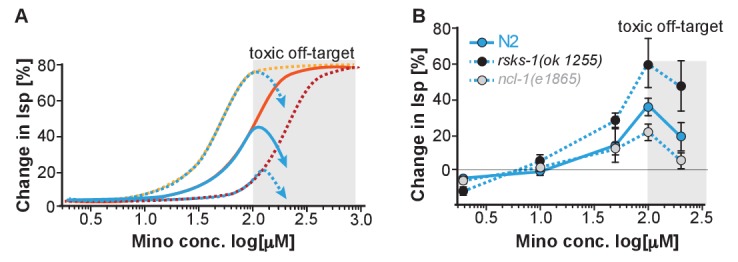
Evidence for a toxic off-target at higher minocycline concentrations.(A) Depicts expected effect on change in lifespan of a translation-independent toxic off-target. Too much translation attenuation by too much minocycline is likely to be detrimental. However, the minocycline concentration to reach this detrimental effect should depend on the endogenous translation rate of each strain and should occur at lower concentrations in rsks-1 mutants and at higher concentration in ncl-1 mutants. The observed detrimental effect however occurs in all strains, N2, ncl-1, rsks-1 at the same minocycline concentration irrespective of their endogenous translation rate. It is therefore more consistent with the engagement of a toxic off-target not related to translation. (B) Same as Figure 5C, showing the shift in dose-response curves and toxic off-target effect between 100 and 200 μM minocycline (shaded gray). Also note that 200 μM minocycline do not cause a drop in lifespan extension in skn-1 mutants (Figure 2) but further extend lifespan suggesting that the expression of the toxic off-target may be regulated by skn-1.